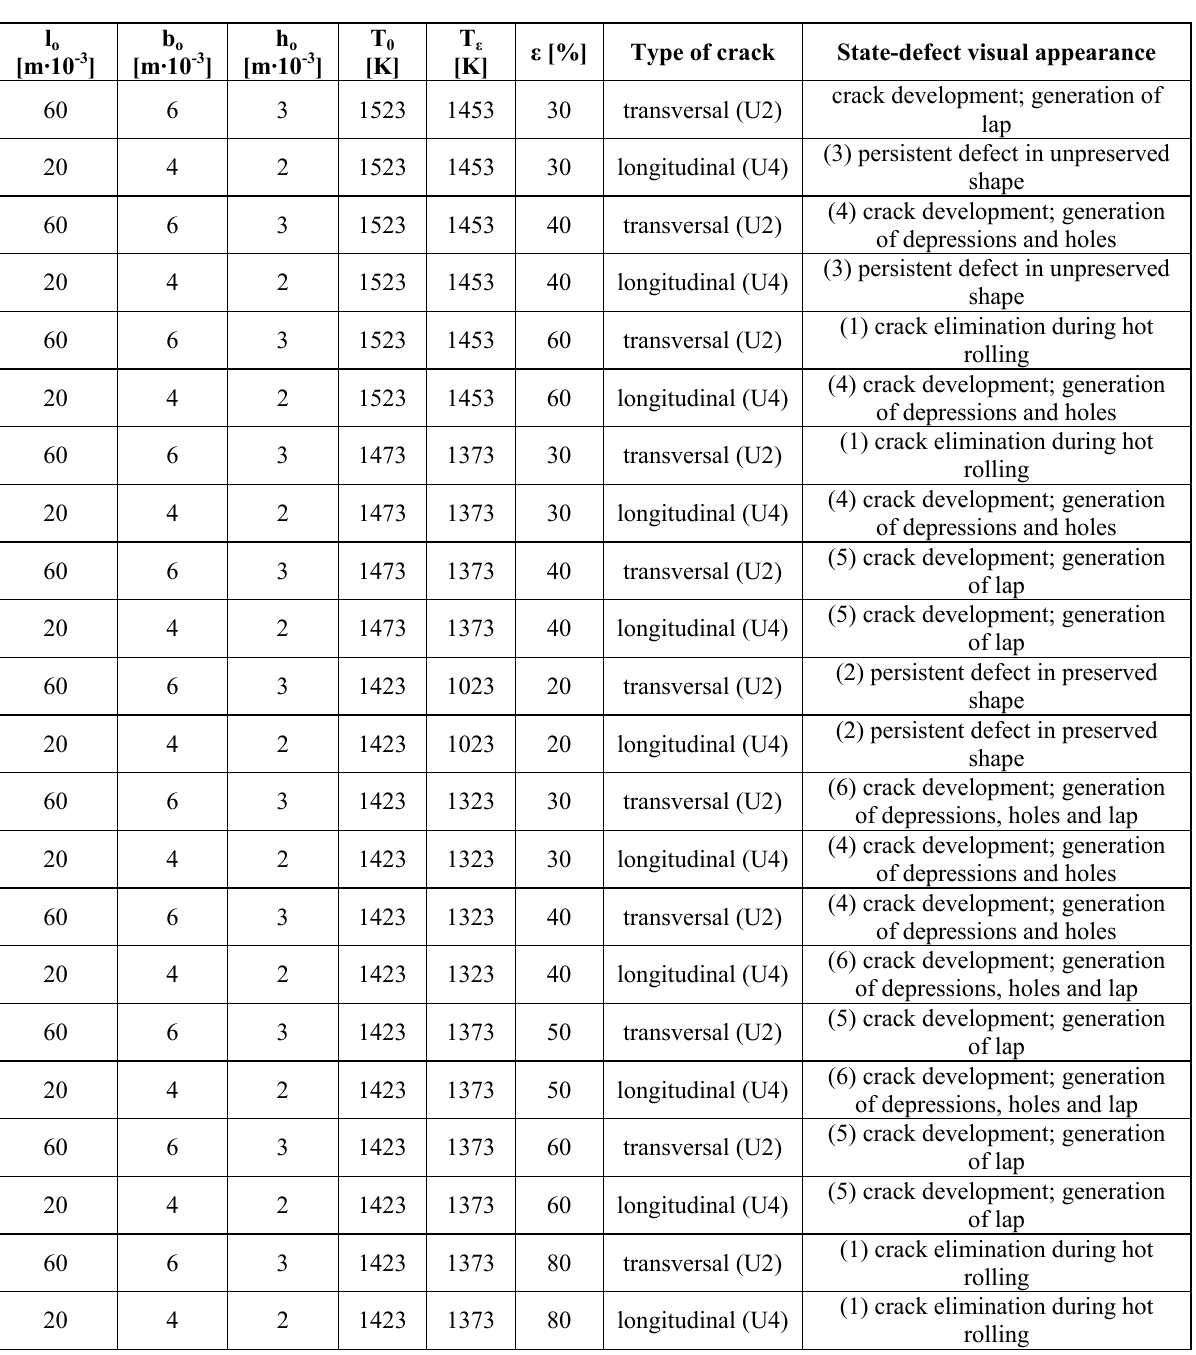
Table 5. State-defect visual appearance after the numerical simulation for given temperature-deformation